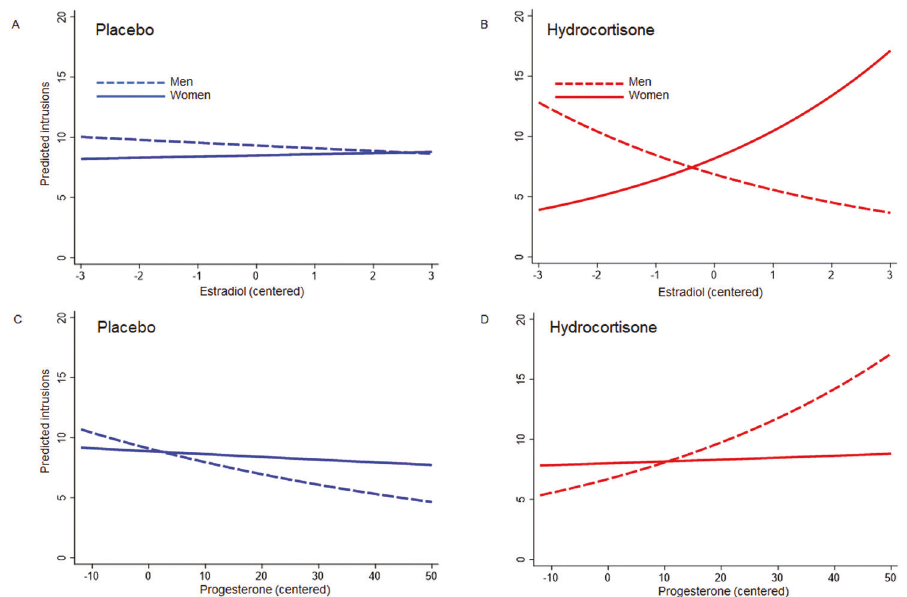
Fig. 4 Hormone-by-sex-by-drug interactions. The association between intrusions and baseline mean-centred estradiol levels ( A , B ) and between intrusions and baseline mean-centred progesterone levels ( C , D ). Dashed lines = men; solid lines = women. Blue = placebo; Red =